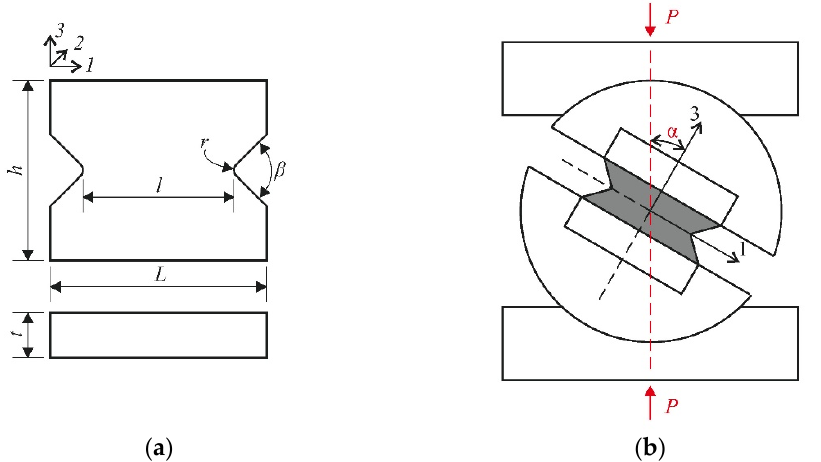
Figure 2. Dimensions of the specimen ( a ) and specimen-loading scheme ( b ).